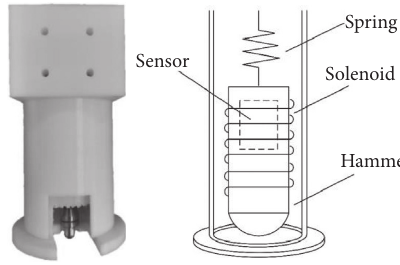
Figure 7: The tapping device and its schematic diagram.